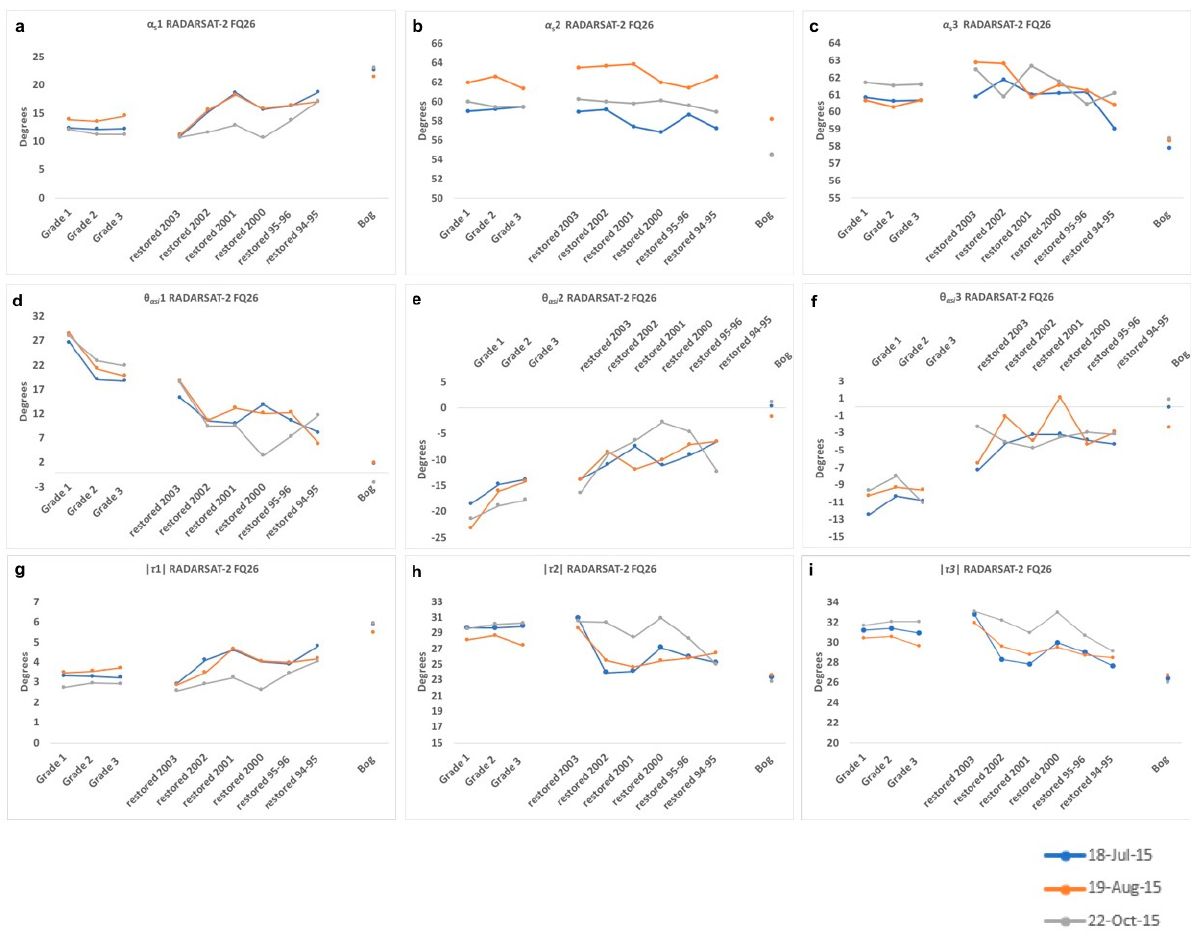
Figure 8. Graphs show the spectral signatures for natural shrub bog, harvested peat, and restored peat derived from RADARSAT-2 FQ26 imagery. ( a – c ) Dominant, secondary, and tertiary scattering-type magnitude, ( d – f ) dominant, secondary, and tertiary scattering-type phase, and ( g – i ) dominant, secondary, and tertiary absolute value of helicity, respectively.